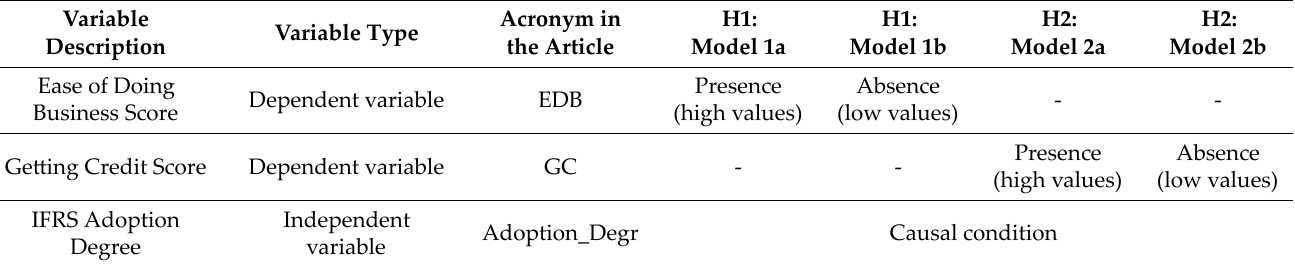
Table 4. Research Models